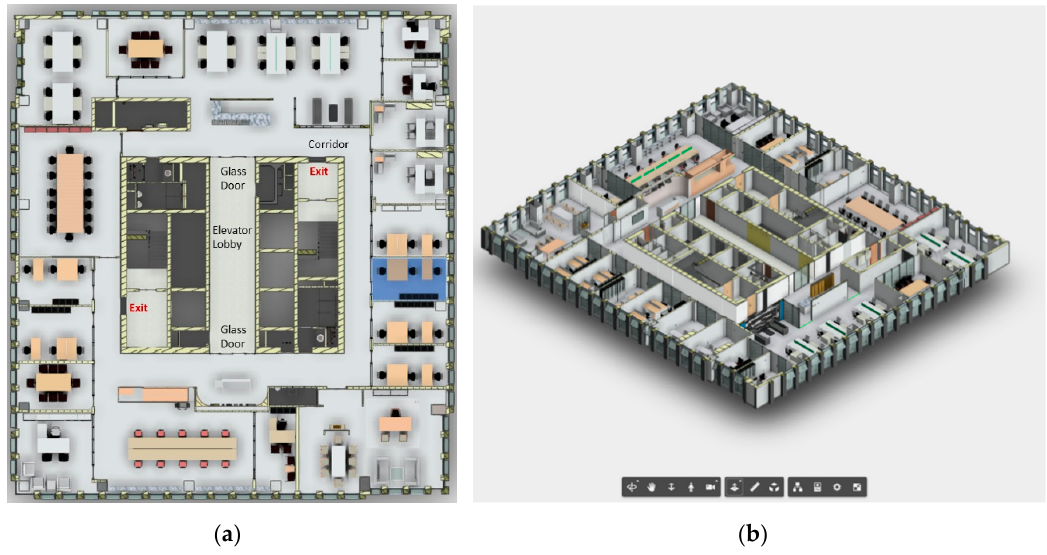
Figure 5. ( a ) Floorplan of the office building, ( b ) building information modeling (BIM) model for the building with navigation tools. building with navigation